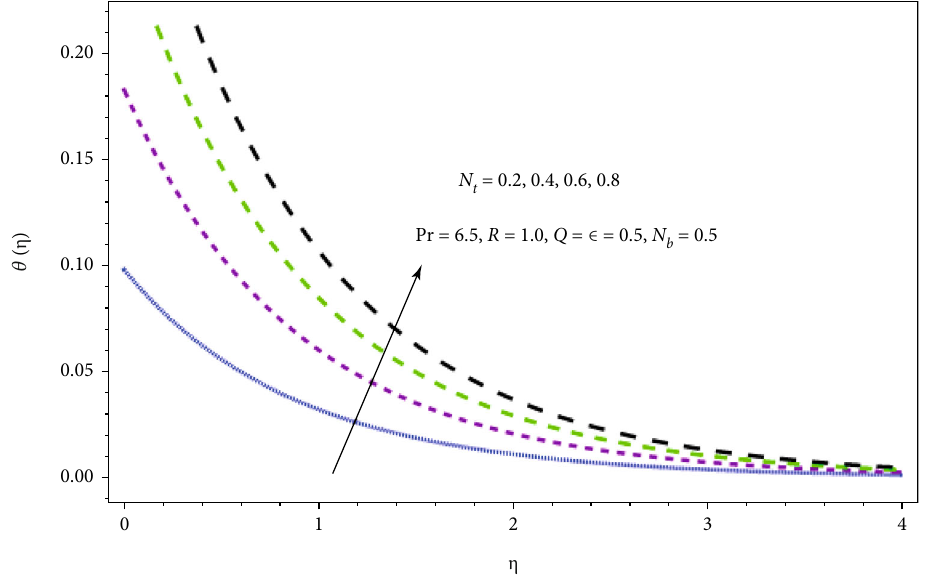
Figure 9: Illustration of the e ff ect of N